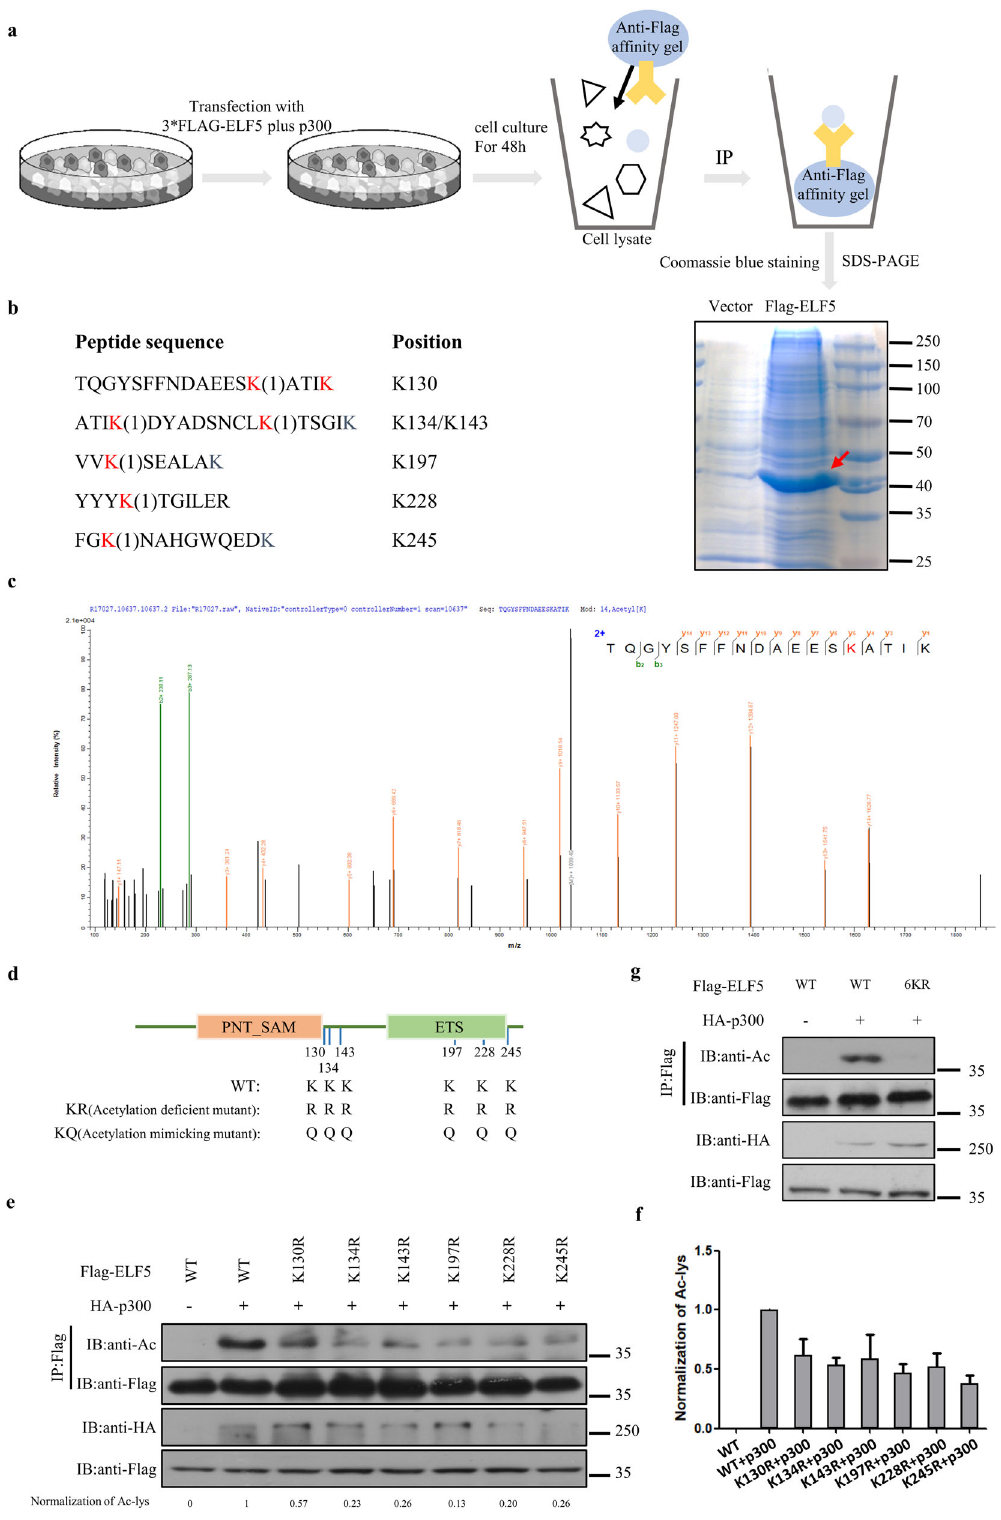
Fig. 3 ELF5 is acetylated at K130, K134, K143, K197, K228 and K245. a Diagram outlining the steps involved in the preparation of sample for mass spectrometry (MS) to identify the acetylation lysine sites of ELF5. b Mass spectrometry identi fi cation of ELF5 acetylation sites in HEK293T cells transfected with expression plasmids for Flag-ELF5 and HA-p300. c MS analysis of the ELF5-derived peptides containing acetylated K130. d Diagram showing the acetylation sites of ELF5 that were mutated. e Effects of lysine to arginine at putative acetylated lysine residues on the acetylation of ELF5. Hela cells co-transfected with Flag-ELF5 WT or mutant Flag-ELF5 plus HA-p300 or not, cell lysis was immunoprecipitated with anti-Flag af fi nity gel and immunoblotted with the anti-AcK Ab. f Quantitative analyses of the acetylation of ELF5 WT and mutants. g The acetylation of ELF5 6KR was abolished. HEK293T cells co-transfected Flag-ELF5 WT or Flag-ELF5 6KR without and with HA- p300. Cell lysis was immunoprecipitated with anti-Flag af fi nity gel and immunoblotted with the anti-AcK